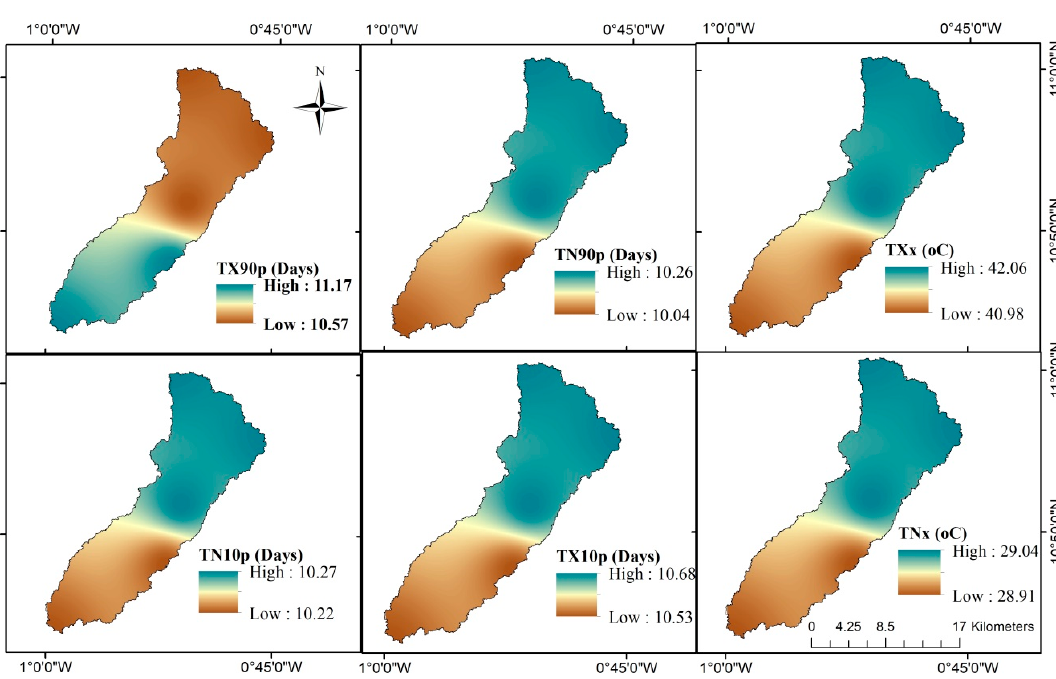
Figure 6. Spatial distribution of Temperature extreme Indices from 1985–2016.